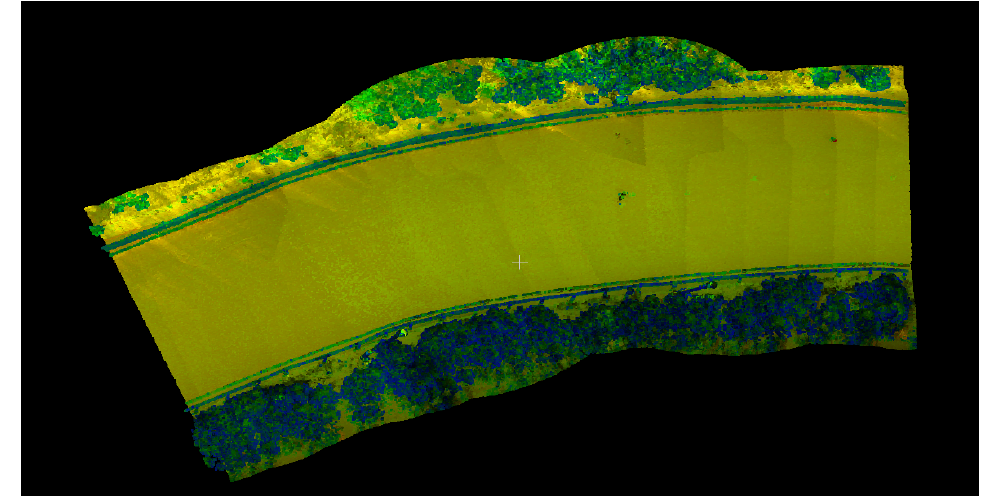
Figure 11. Adding colors to the datasets of Figure